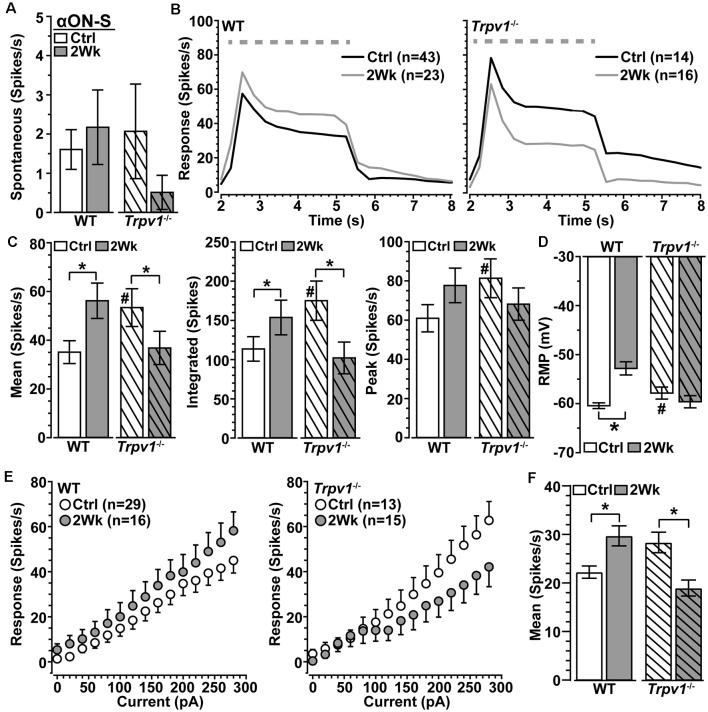
Opposing influence of elevated IOP on WT vs. Trpv1−/− αON-S RGCs. (A) The spontaneous firing rate of WT and Trpv1−/− αON-S RGCs is not affected by elevated IOP (p ≥ 0.07). (B) Response to light (dashed line) increases for WT αON-S RGCs with elevated IOP but decreases for Trpv1−/−. (C) Elevated IOP increased the mean and integrated light response for WT αON-S RGCs (*p ≤ 0.04), but decreased both for Trpv1−/− (*p ≤ 0.05). The integrated response for Trpv1−/− Ctrl cells exceeded that for WT (#p = 0.05), as did mean and peak (#, see Figure 2). (D) RMP for WT αON-S RGCS becomes more depolarized with elevated IOP (−53 ± 1.4 vs. −60.6 ± 0.5 mV; *p < 0.001); for control, Trpv1−/− was more depolarized (#, see Figure 2). (E) The voltage response of WT and Trpv1−/− αON-S RGCs following brief (1 s) pulses of depolarizing current (0–280 pA; 2 s inter-stimulus interval). (F) Elevated IOP significantly increased voltage response averaged across current pulses for WT αON-S RGCs (*p = 0.01) but decreased it for Trpv1−/− compared to Ctrl (*p = 0.002). Statistics: Mann–Whitney test (A), Student’s t-tests (C,D), Kruskal–Wallis test, Dunn’s post hoc
(F). Data = mean ± SEM.